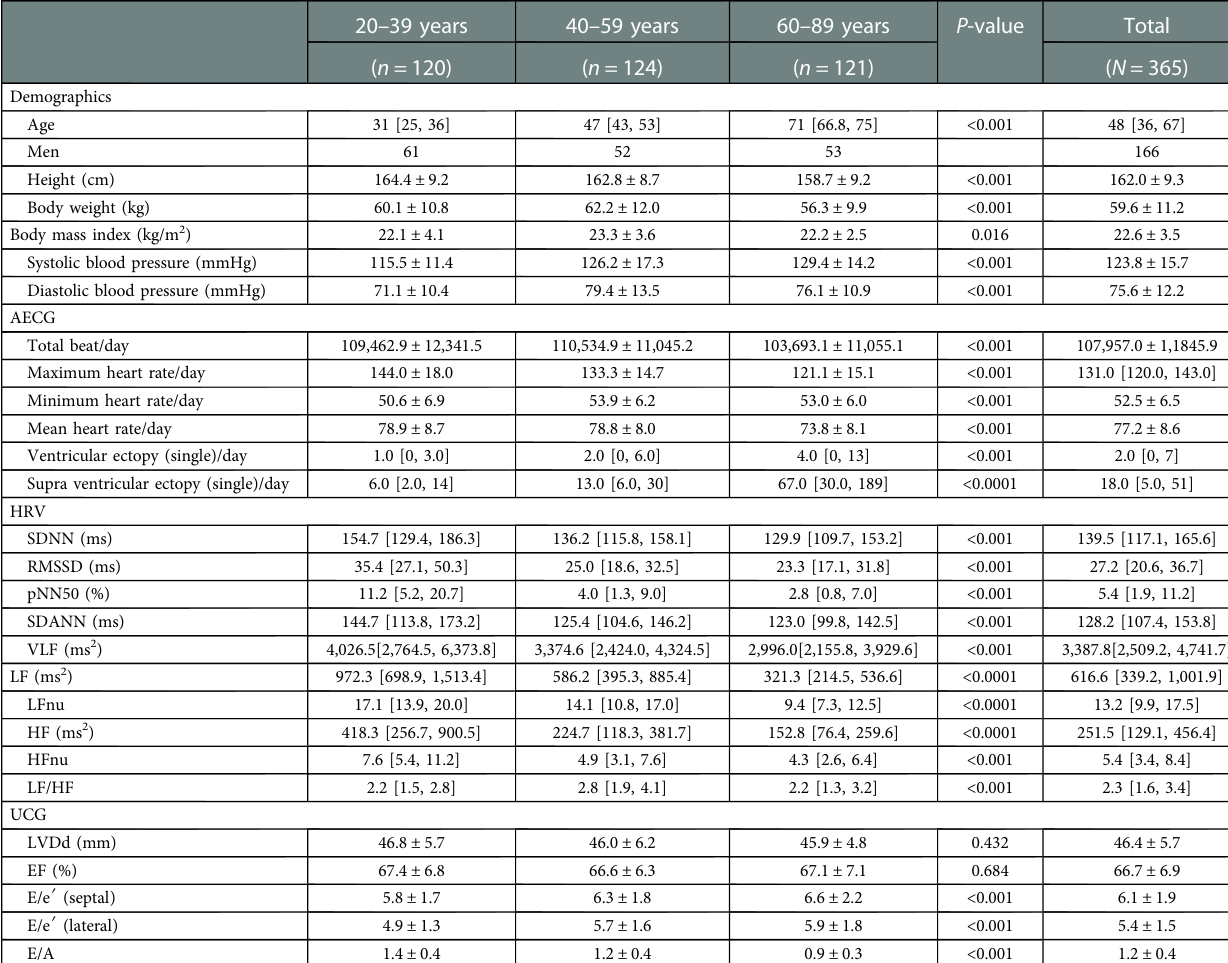
TABLE 1 Demographics and Holter ECG and UCG